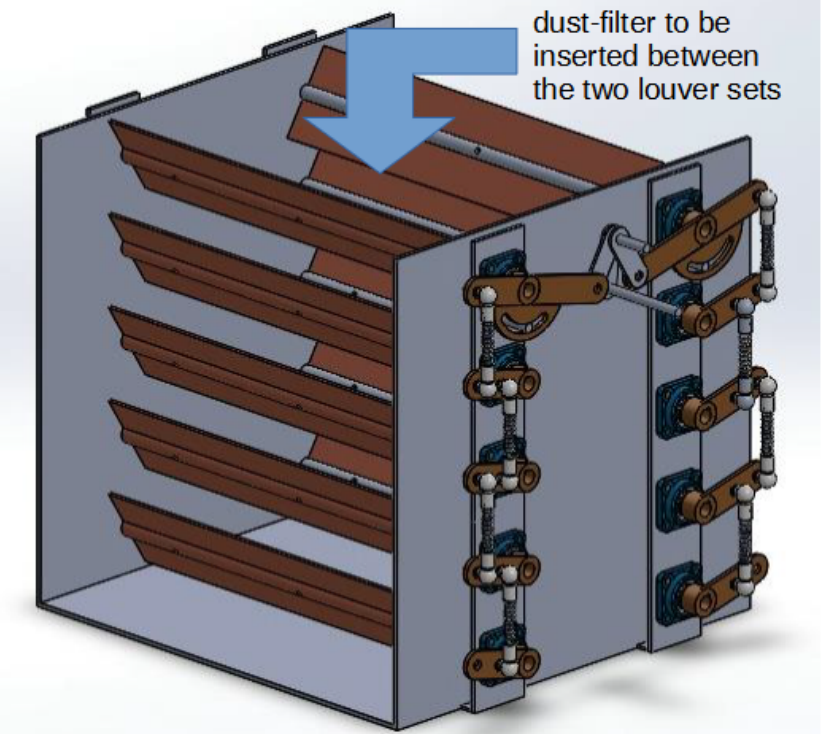
Figure 2. Conceptual design of the louvers ‘cassette’ assembly to provide safe removal of the dust filter. The louvers are closed for the filter’s replacement; the all ‘cassette’ assembly is pulled out from the air purifier, and the filter can be safely removed.